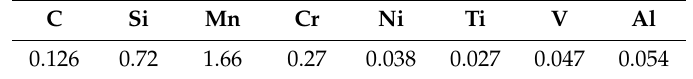
Table 1. Mean chemical composition (wt %) (Spectruma GDA 750 Analyzer) of the steel. C